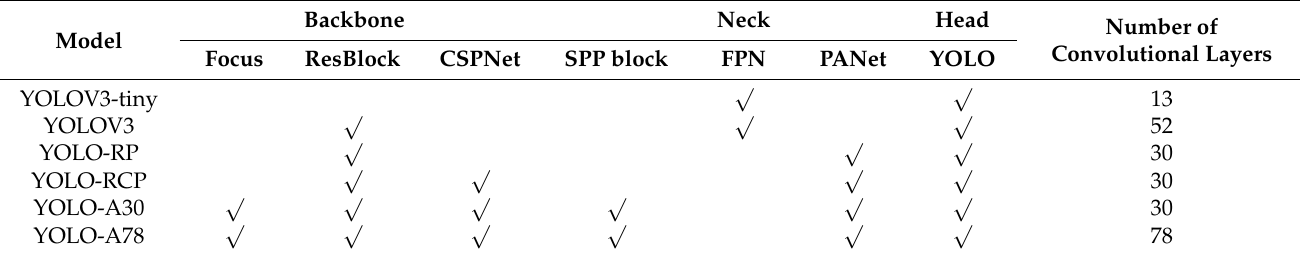
Table 2. Six types of feature extraction networks composed of different network components.